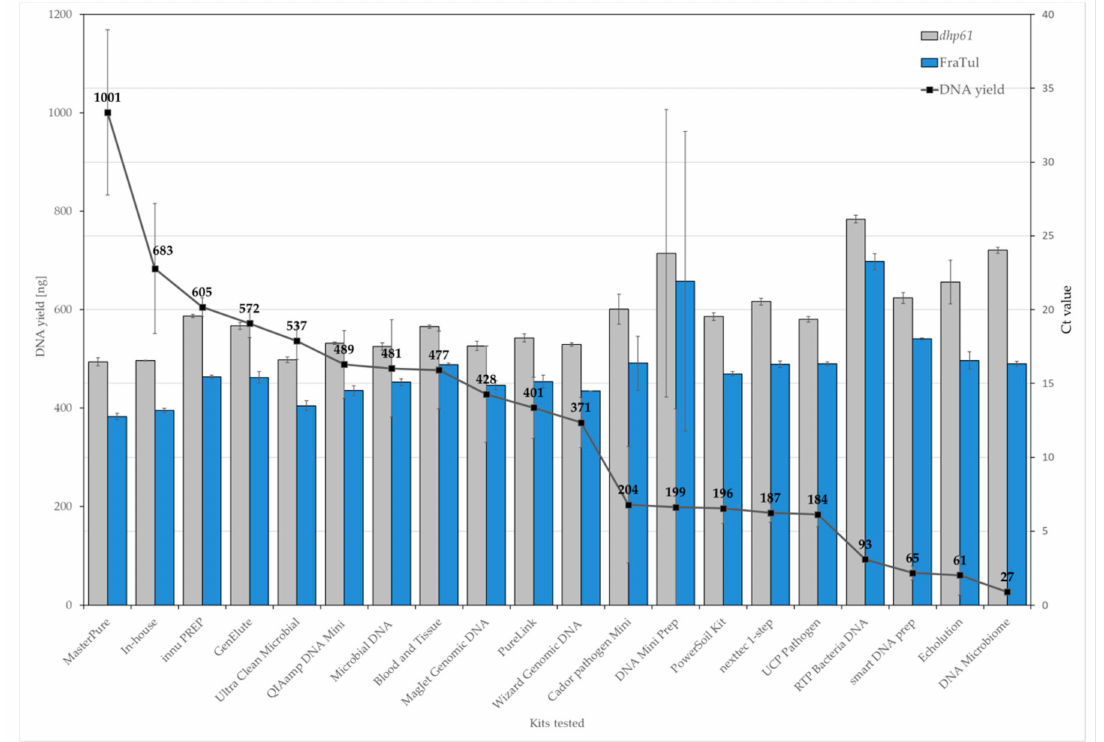
Figure 1. DNA extraction e ffi ciency depends on the method (kit) used. Average DNA yields (black line) and qPCR amplification results of samples containing B. anthracis ( dhp 61, grey columns) or F. tularensis (16S FraTul, blue columns) cells, obtained with the following 20 commercial kits: (1) MasterPure Complete DNA and RNA Purification kit; (2) In-house protocol, based on the DNA Investiagtor kit; (3) innu PREP DNA Mini kit; (4) GenElute Bacterial Genomic DNA kit; (5) DNeasy Ultra Clean Microbial kit; (6) QIAamp DNA Mini kit; (7) NucleoSpin Microbial DNA Mini kit; (8) DNeasy Blood and Tissue kit; (9) MagJet Genomic DNA kit; (10) PureLink Microbiome DNA Purification kit; (11) Wizard Genomic DNA Purification kit; (12) QIAamp Cador pathogen Mini kit; (13) DNA Mini Prep; (14) DNeasy PowerSoil kit; (15) nexttec 1-step DNA isolation kit for Bacteria; (16) QIAamp UCP Pathogen Mini kit; (17) RTP Bacteria DNA Mini kit; (18) smart DNA prep; (19) Echolution Tissue DNA Micro kit; and, (20) QIAmp DNA Microbiome kit. Data are presented as the mean of triplicates and the error bars show standard